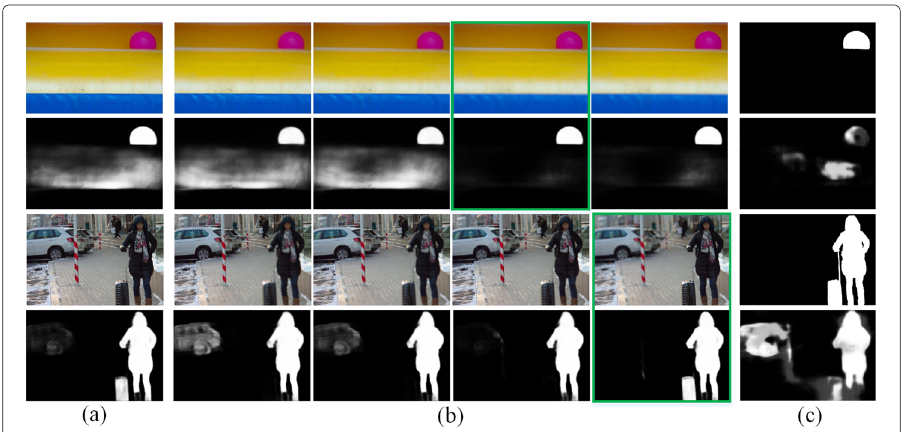
Fig. 1 Motivation of the proposed method. a All-focus image and saliency maps by state-of-the-art 2D method SCRN [11]. b Focal stacks and corresponding saliency results by SCRN. c Ground truth (the first and third row) and results by state-of-the-art 4D method DUT [7] (the second and forth row). Green boxes denote the best F -measure of